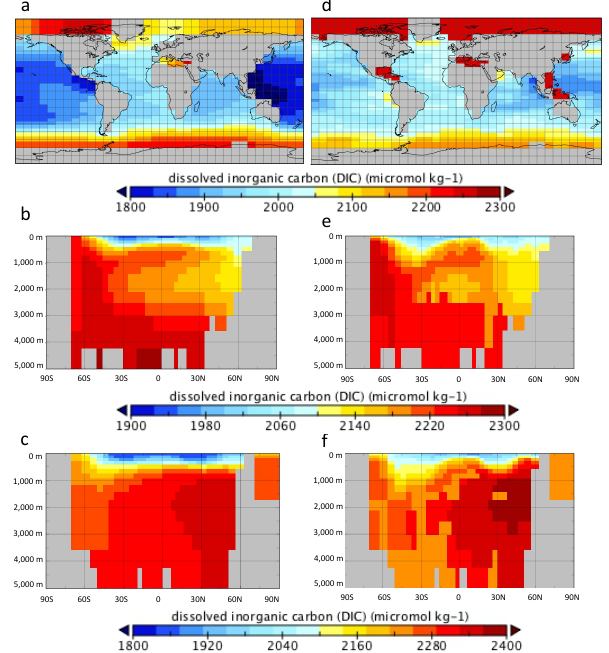
Fig. 8. Dissolved inorganic carbon: (a) , (b) and (c) EFPC ensem- ble averages, (d) , (e) and (f) observations (Key et al., 2004). Up- per panels are surface fields ( ∼ 81m depth). Middle panels are At- lantic cross sections (25 ◦ W). Lower panels are Pacific cross sec- tions (155 ◦